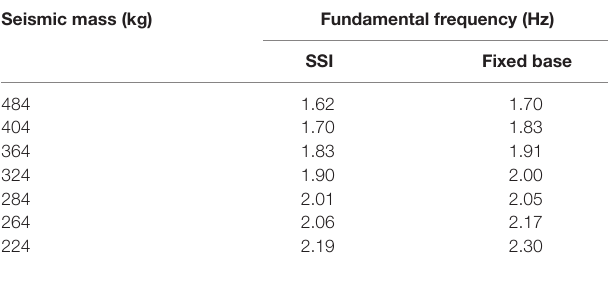
TaBle 3 | Fundamental frequencies of the model obtained from the ssi and fixed-base cases. seismic mass (kg)